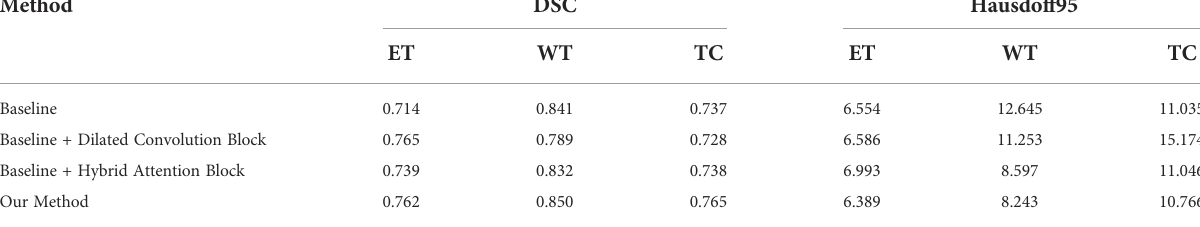
TABLE 3 Ablation study of our proposed method on BraTS 2020 dataset. Method